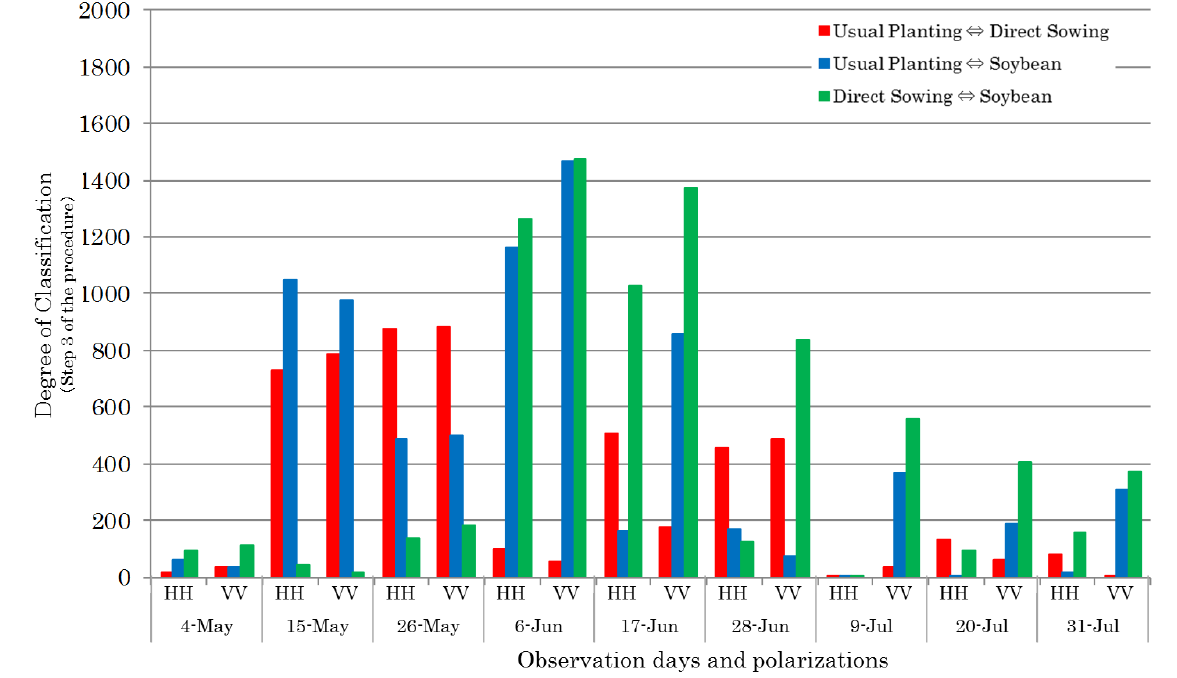
Figure 4. Time series variation of the statistical distance between samples of the study